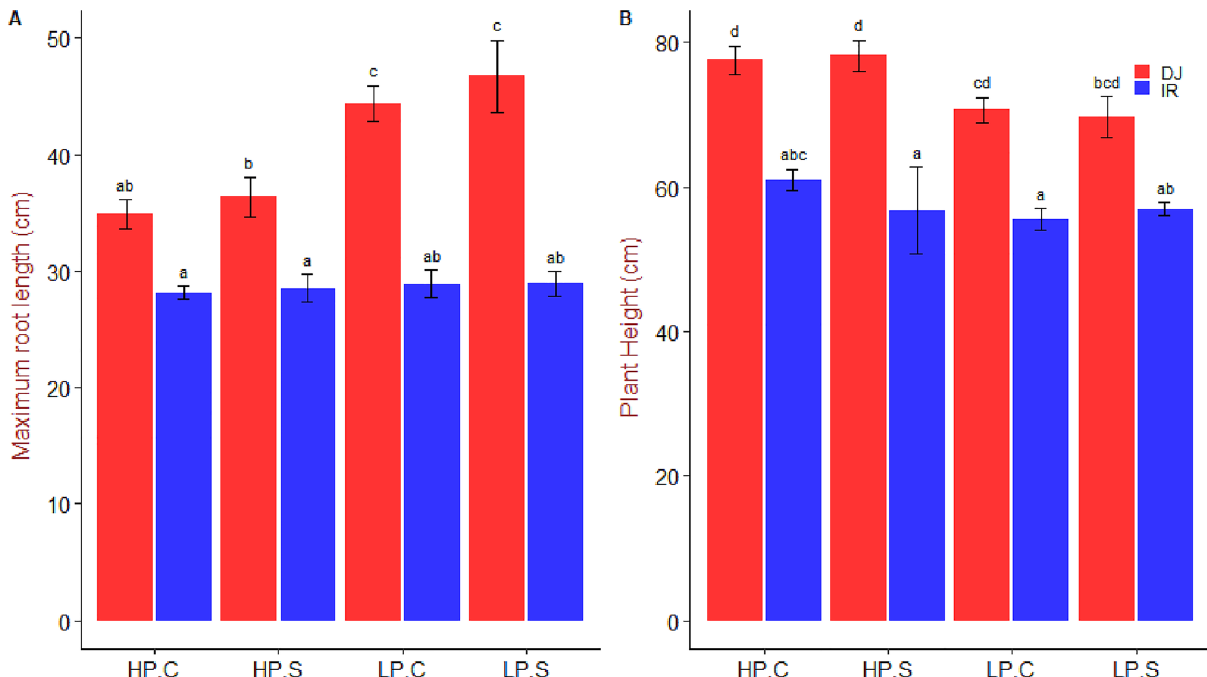
Figure 2. Maximum root length and plant height of DJ123 and IR64 under varying phosphorus supply. Data are the mean ± SE of four independent replicates. ‘HP’ and ‘LP’ stand for high- and low-phosphorus supply, respectively. Plants were grown on HP and LP treatments for 40 days after germination. Then, both groups were splitted into two sub-groups. Phosphorus supply was continued as usual for one sub-group of each treatment (labelled as ‘C’) and stopped for the other group (labelled as ‘S’). After approximately 24 and 48 h, LP and HP sub-groups were harvested, respectively. Significant differences among treatments were determined by ‘generalised least square’ model, separated by Tukey’s test (P < 0.05), and are indicated by different